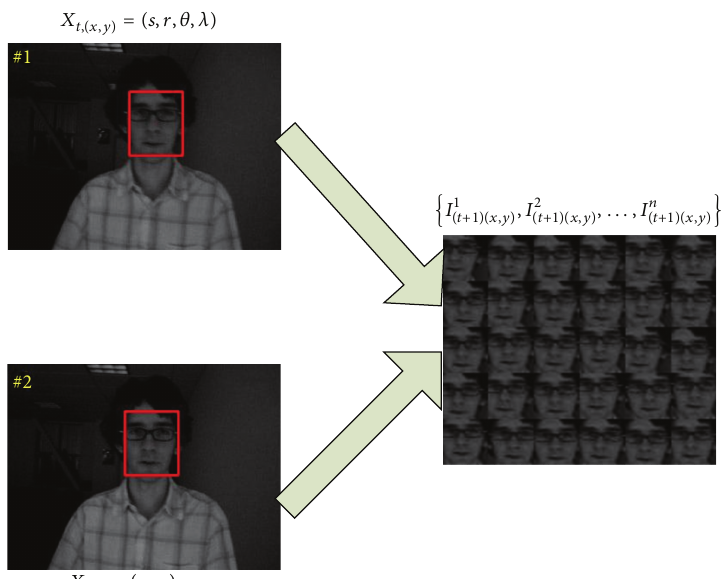
Figure 4: Obtaining target set of